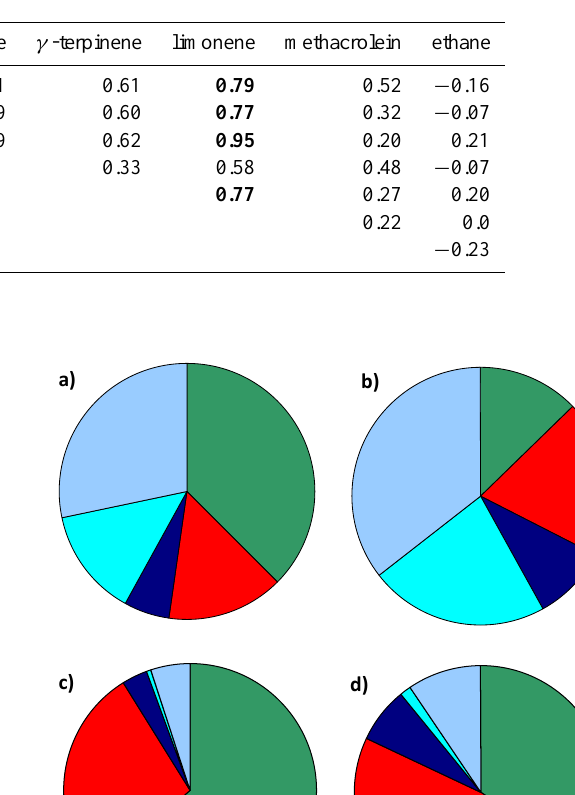
Table 3. Spearman’s rank correlation coefficients to illustrate the extent of correlation between monoterpenes, isoprene, methacrolein and ethane. VOC-monoterpene correlations are derived based upon 478 data pairs. All other VOC correlations are derived from 534 data pairs. The strongest correlations are highlighted in bold.